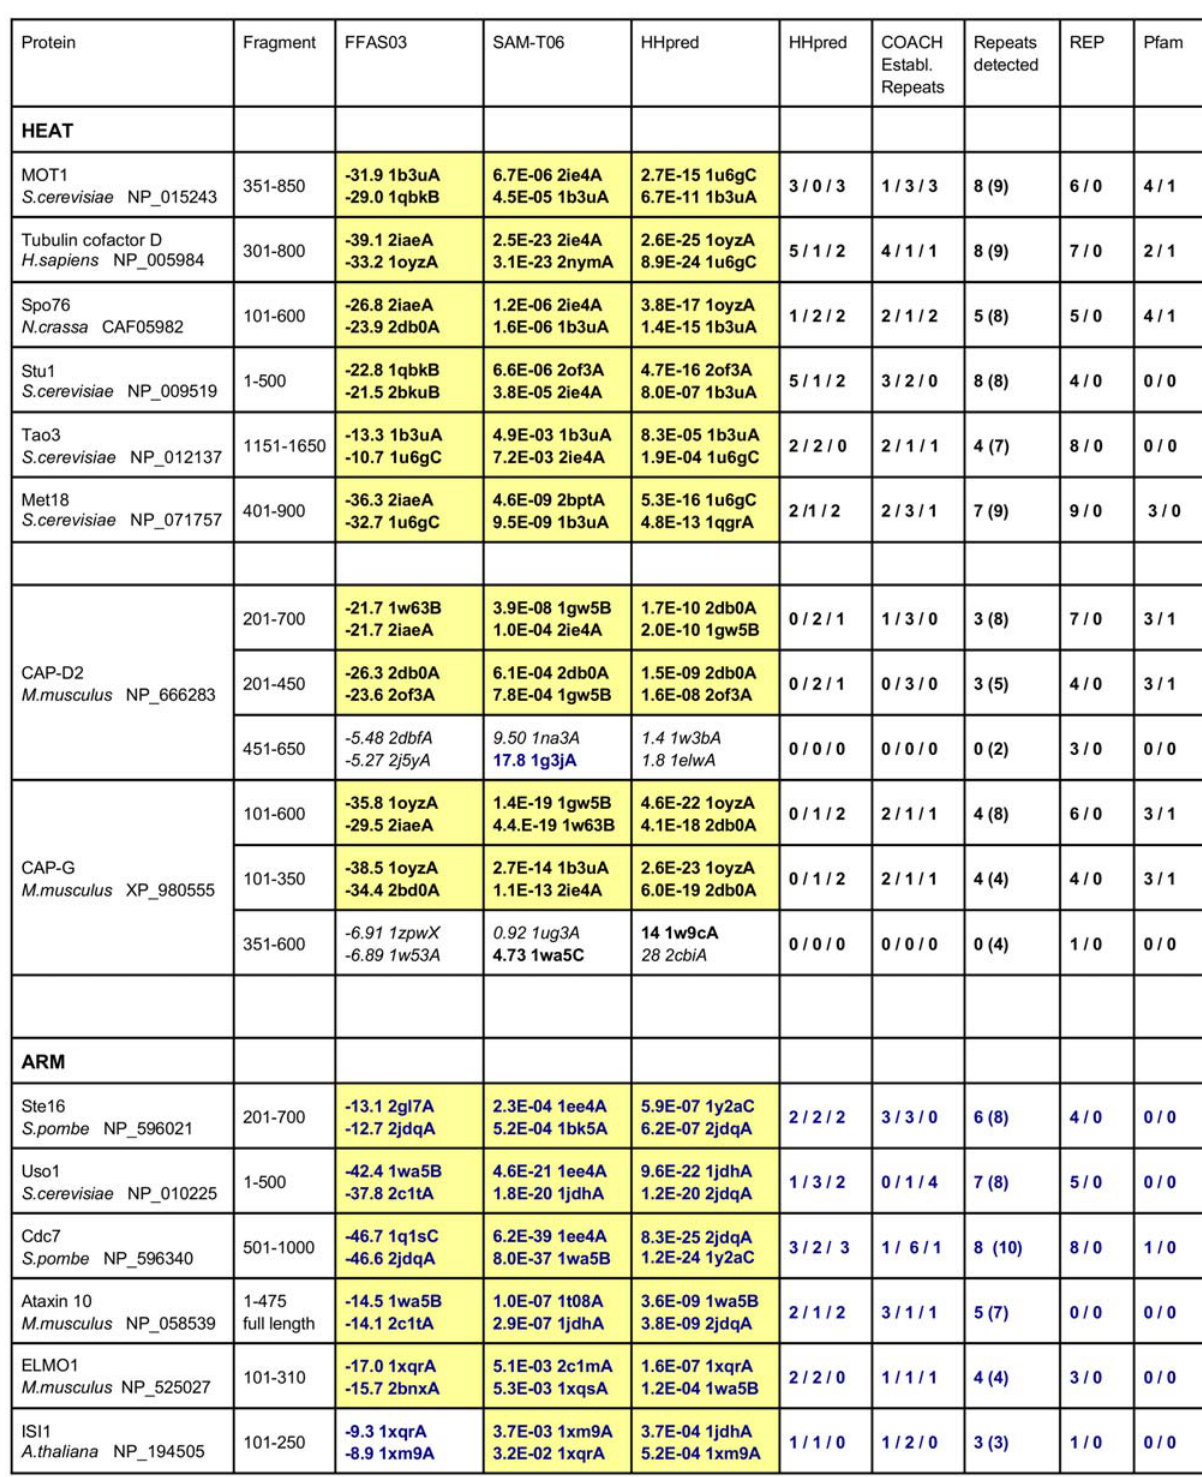
Figure 9. Fold prediction and individual repeat analysis of candidate proteins. The results of the application of fold prediction and individual repeat analysis to selected bona fide HEAT and ARM repeat proteins fragments are shown. The two top hits retrieved from fold prediction servers FFAS03 [25], SAM-T06 [24] and HHpred [16] are given. HEAT (both eukaryotic and prokaryotic) and ARM templates are shown in bold font, ARM templates in blue. Highlighted in yellow are matches with ‘‘significant’’ scores (see Methods). HHpred and COACH(Established Repeats) results were grouped in four classes as described in the text and the numbers of repeats falling in the three better scoring classes are shown here. Repeats detected are those with matches better than the lowest threshold by either HHpred or COACH(Established Repeats); given in brackets is the number of potential repeats, i.e. identified repeats plus additional helical segments of appropriate size. REP and Pfam results are for subsignificant/significant matches as returned by the servers.